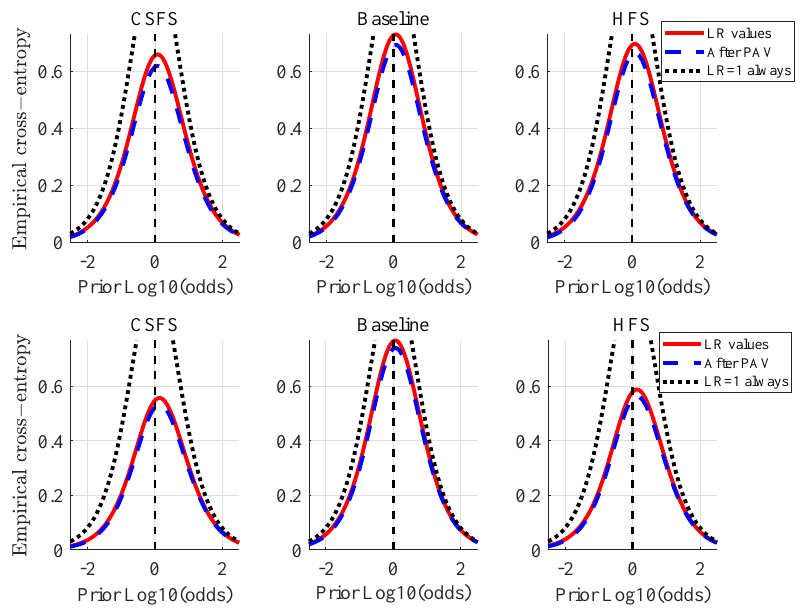
Figure 13. ECE plots: stabilized videos vs. RT1 (first row) and RT2 (second row).